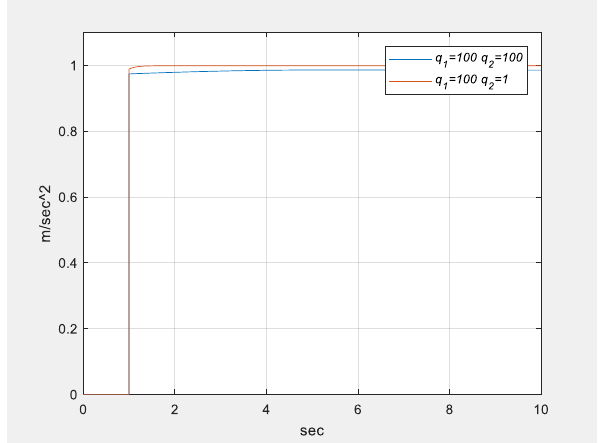
 and the .  and the s  and the θ s and the s s